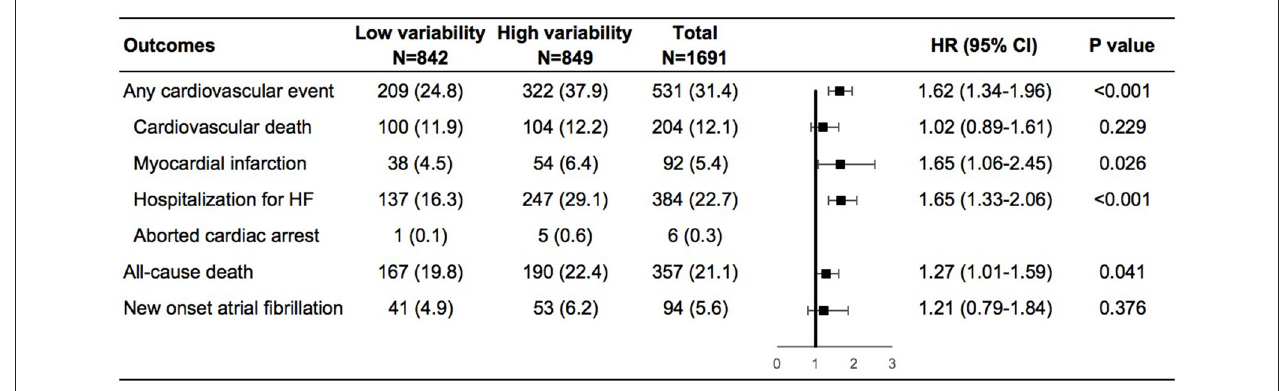
FIGURE 1 | Risk of outcomes in the high vs. low body-weight variability in multivariable model. The multivariable model was adjusted for diuretics, mean body weight, change in weight, age, sex, race, smoking status, diabetes status, atrial fibrillation, peripheral arterial disease, previous hospitalization for chronic heart failure, prior myocardial infarction, known stroke, chronic obstructive pulmonary disease, New York Heart Association class, systolic blood pressure, heart rate, ejection fraction, estimated glomerular filtration rate, number of weight measurement. HF, heart failure; HR, hazard